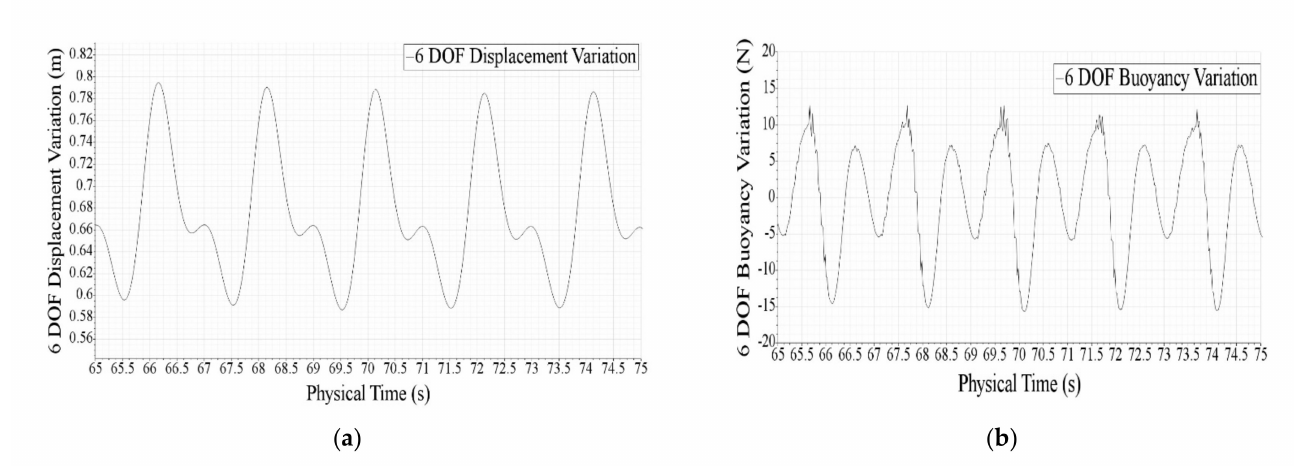
Figure 4. Image of hydrodynamic properties. ( a ) displacement variation; ( b ) buoyancy